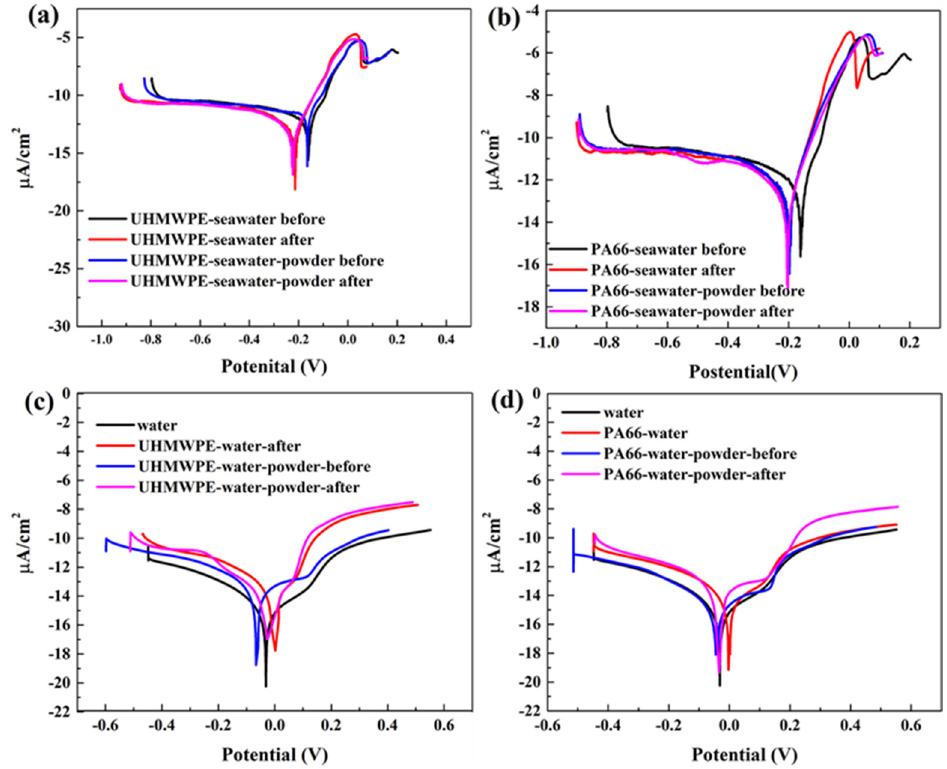
Figure 14. Polarization curve measured using electrochemical workstation: ( a ) UHMWPE pin in seawater; ( b ) PA66 pin in seawater; ( c ) UHMWPE pin in water; ( d ) PA66 pin in water.